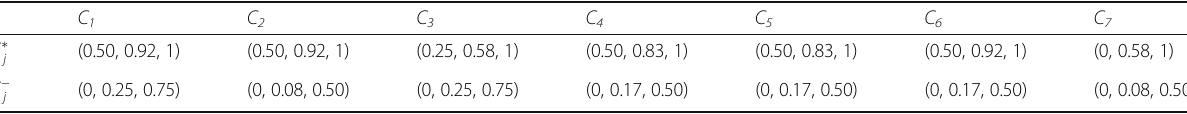
Table 5 Calculated f (cid:2) j and f − j for each criterion C 1 C 2